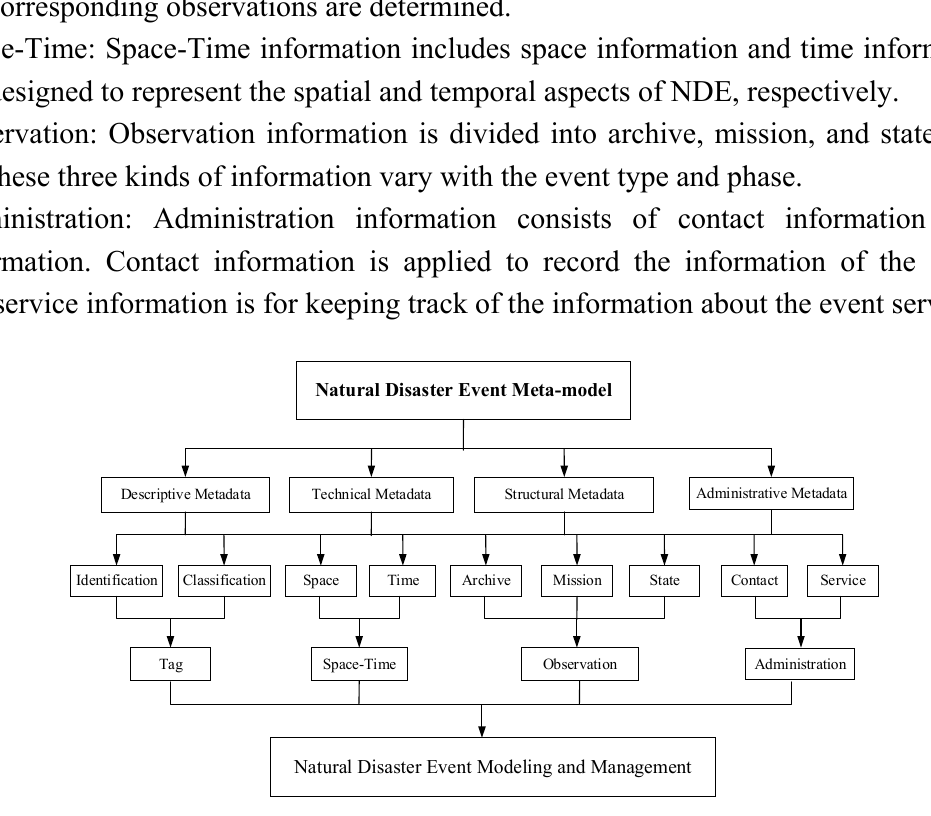
Figure 2. Organization of the hazard